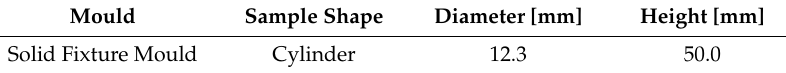
Table 4. Mould characteristics.